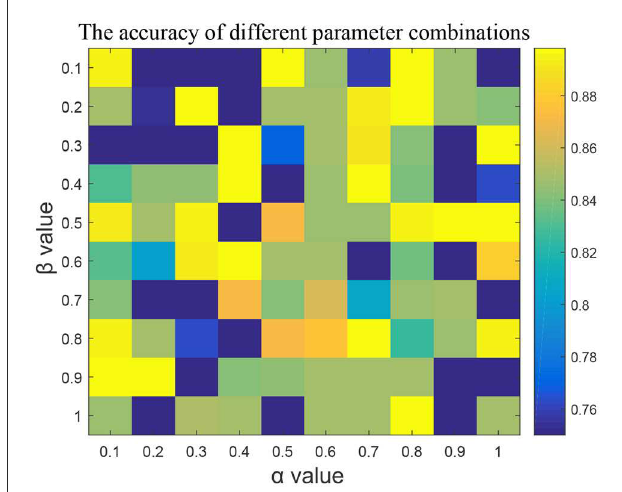
FIGURE2 The effect of α and β parameters in mutcorLasso algorithm. As the color is closer to yellow, the higher the accuracy of the classification is.